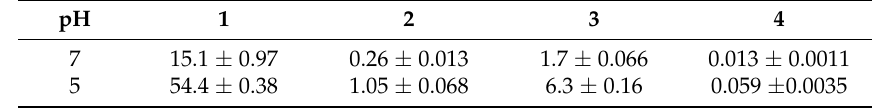
Table 2. Inhibition constant ( K i ) values ( µ M) for the selected sp 2 -iminosugar chaperone candidates 1 – 4 against human β -glucocerebrosidase (GCase). 1 Inhibition was competitive in all the